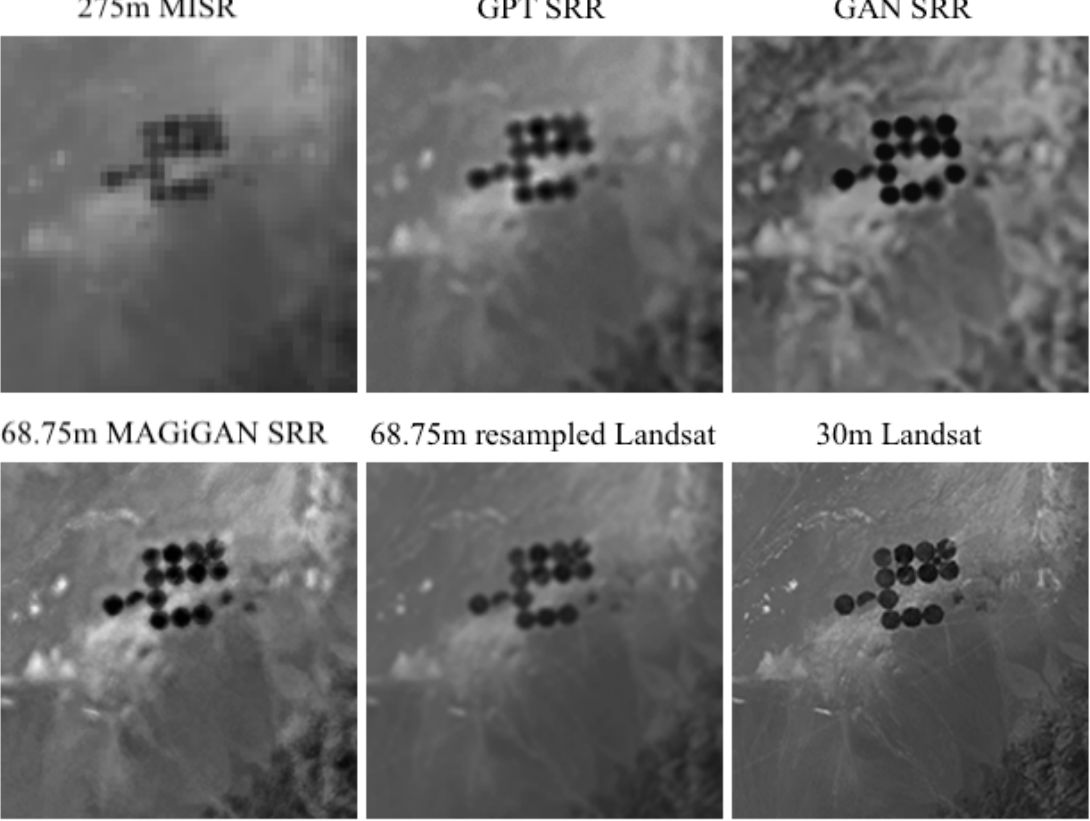
Figure 7. A comparison of the 275 m original MISR L1B2 red band image, GPT SRR result, generative adversarial network (GAN) SRR result, 68.75 m MAGiGAN SRR result, 68.75 m downsampled Landsat red band image, and the 30 m original Landsat red band image.